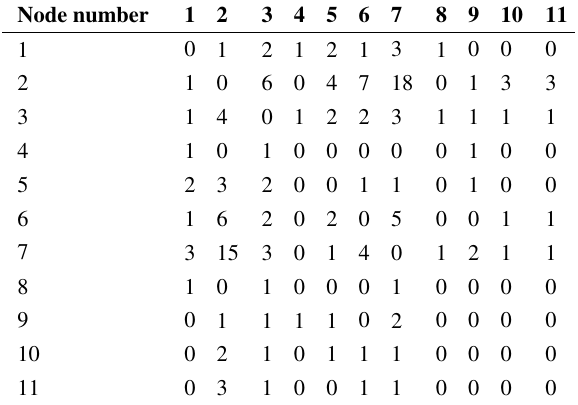
Table 1 Freight volume between urban nodes (unit: